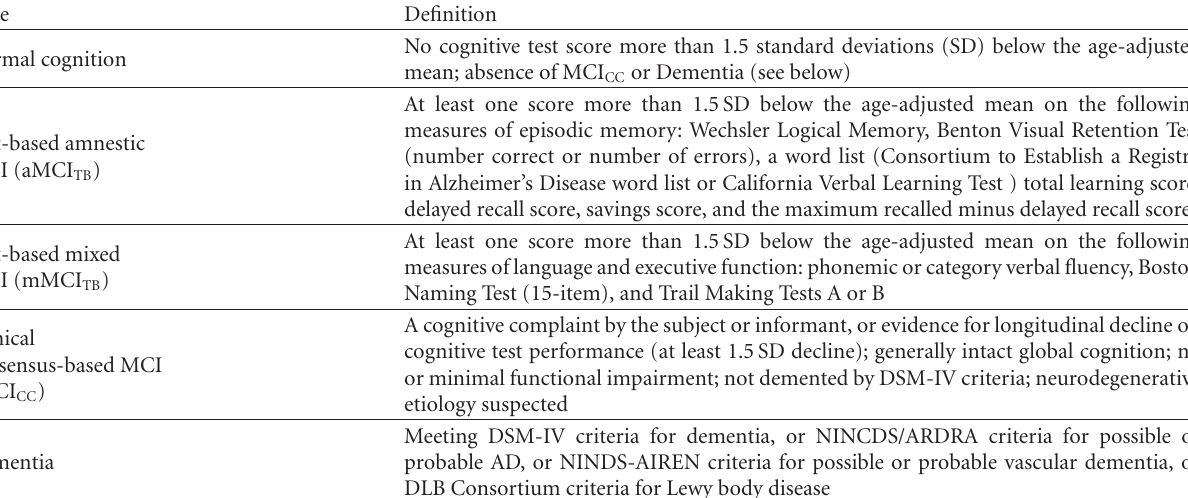
Table 1: Criteria for state classification.